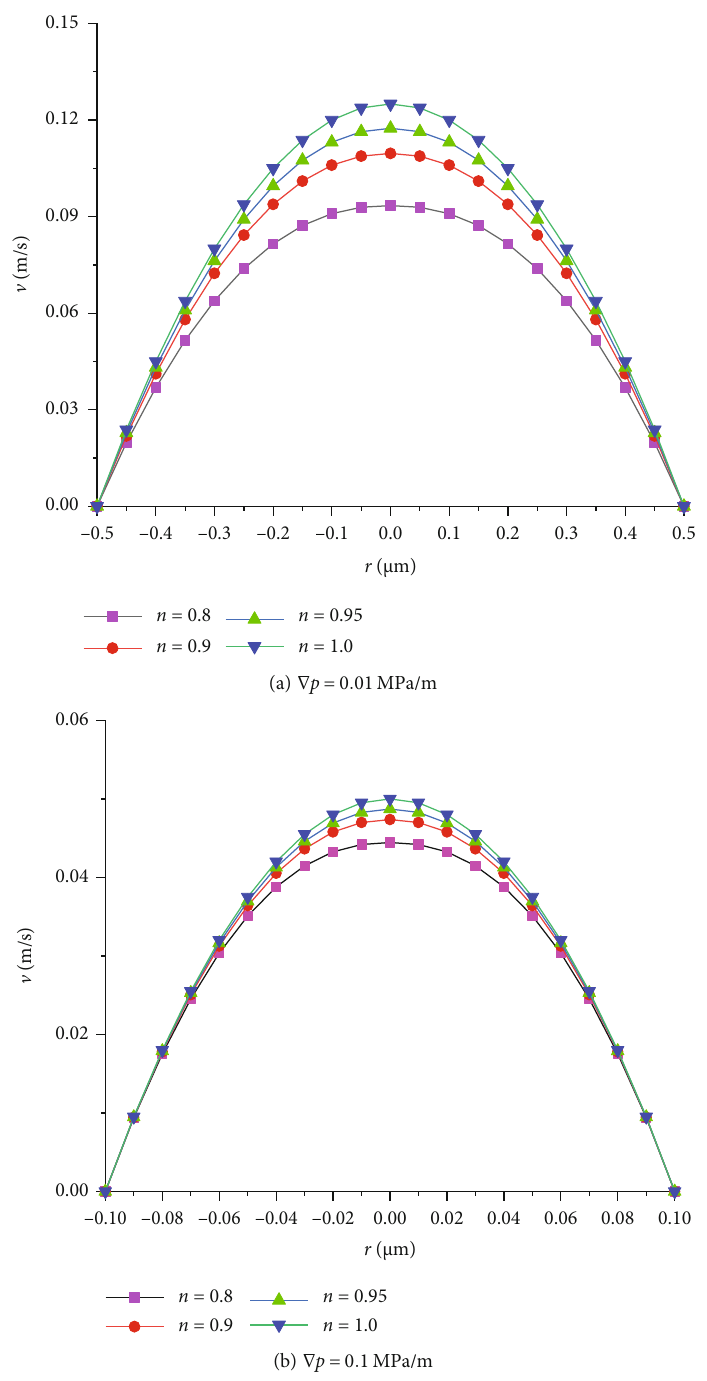
Figure 2: Pro fi le of pipe diameter and microtubule velocity in